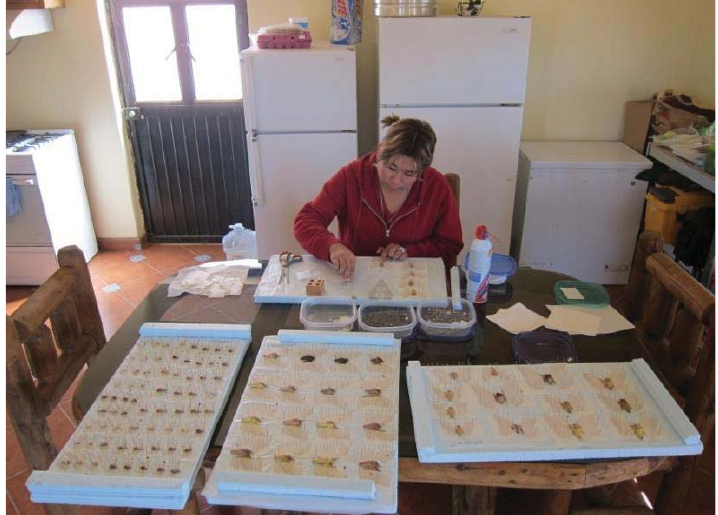
Figure 4. Scheer trained his housekeeper, Paz, one of the local Mayo indigenous people from near Las Bocas, to help with the mounting of the moth